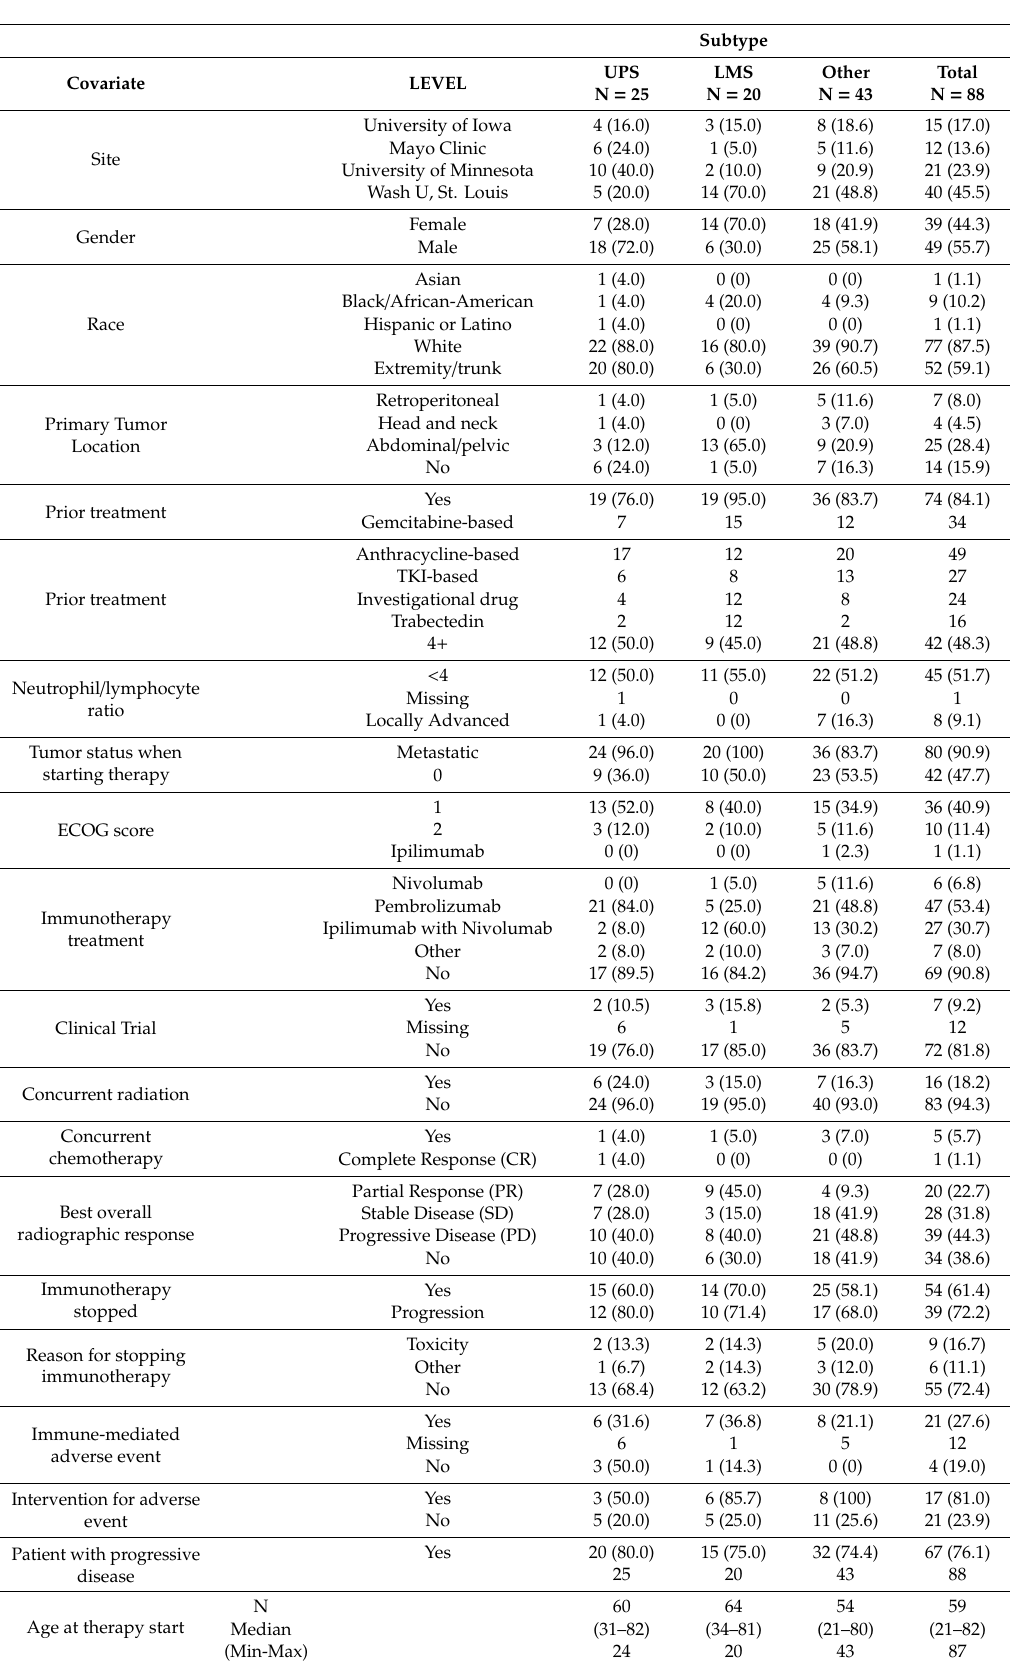
Table 1. Patient baseline